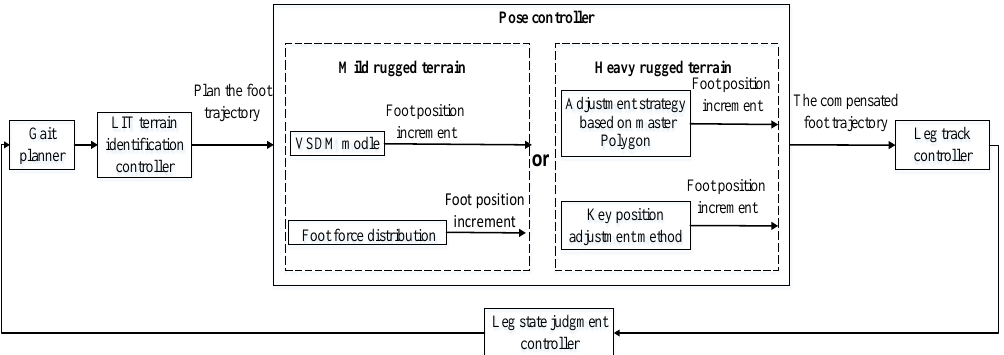
Figure 14. The control process diagram when the hexapod robot crosses rugged terrain.